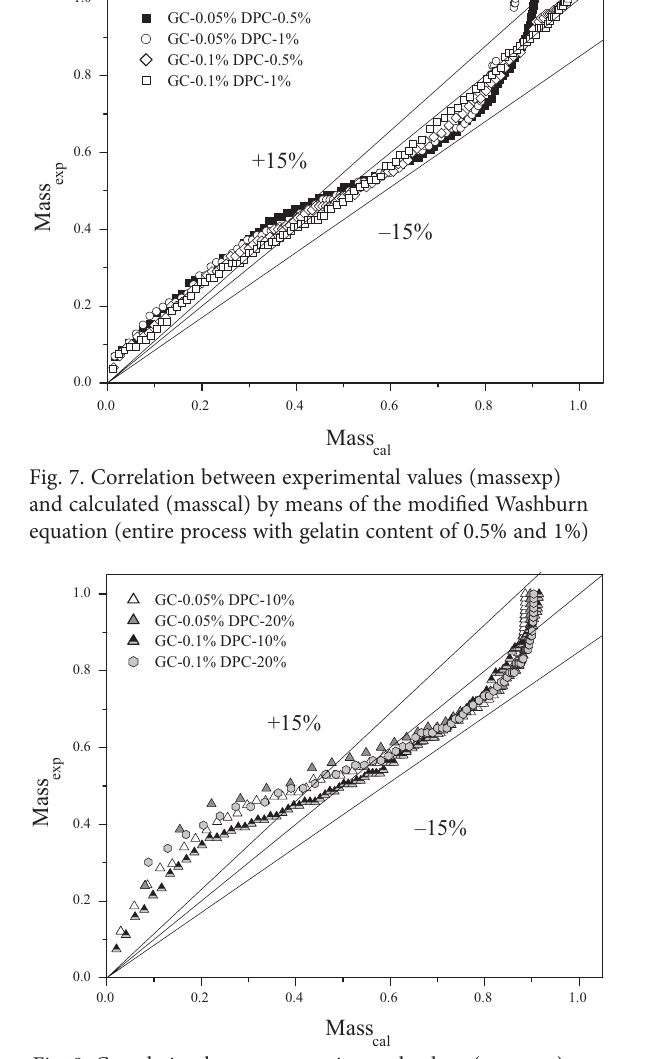
Fig. 8. Correlation between experimental values (massexp) and calculated (masscal) by means of the modified Washburn equation (entire process with gelatin content of 10% and 20%)